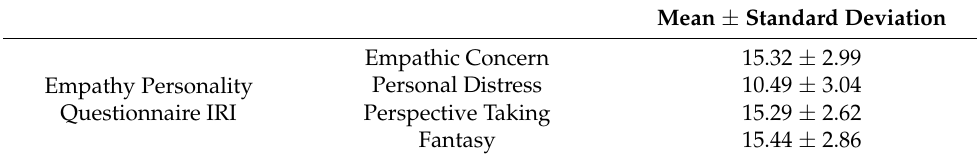
Table 1. Results of personality questionnaires IRI.